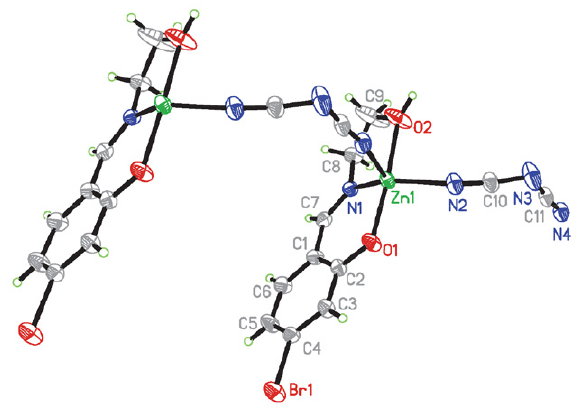
Fig. 3. Molecular structure of complex 2